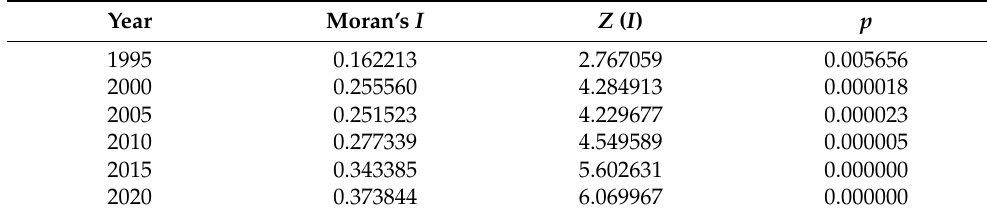
Table 3. Global Moran’s I statistics of food